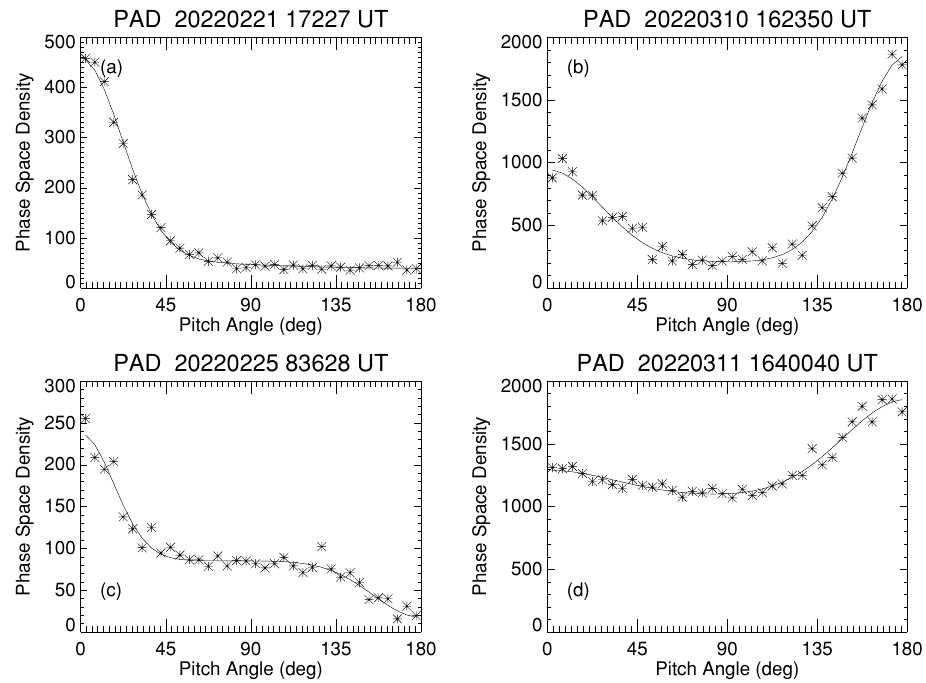
Figure 2. Examples of PADs of interest in this paper and the model fits obtained through the analysis described in the text. In each case the date/time of the PAD is recorded at the top of each plot, and we plot the PSD as a function of pitch angle, with the data points plotted as asterisks and the model fit plotted as the solid curve. All plots shown score well on the quality of fit metric described in the text. Examples presented are classed as: ( a ) a unidirectional strahl in which the PSD of the field-aligned component exceeds that of the perpendicular component by a factor >2; ( b ) a bi-directional strahl in which both field- and anti-field aligned components exceed that of the perpendicular component by a factor >2; ( c ) a deficit in the anti-field aligned component that falls to <50% of the perpendicular component; ( d ) a quasi-isotropic distribution with no significant beams or